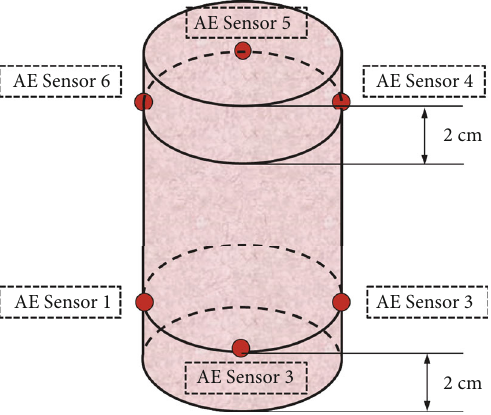
Figure 1: Schematic diagram of AE sensors distribution.